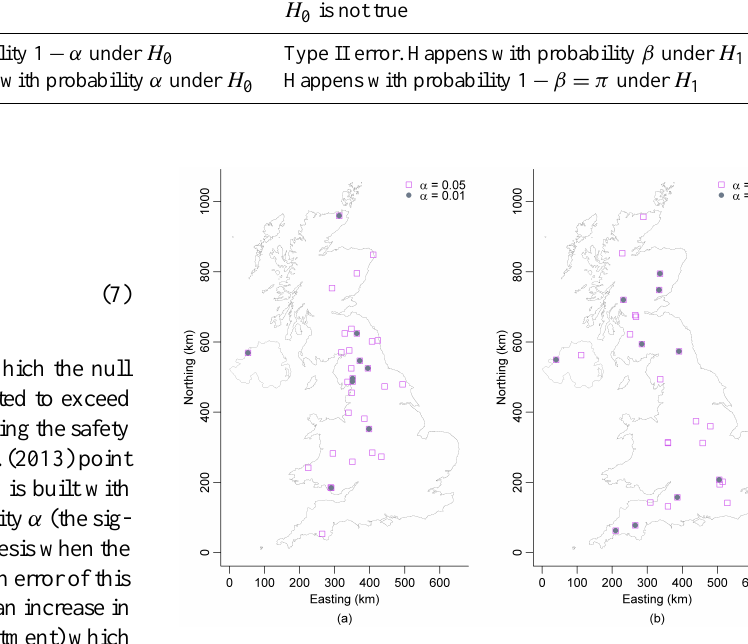
Fig. 12. (a) Sites for which the null hypothesis H 0 : β 1 ≤ log ( 1 . 2 )/ 85 is rejected. (b) Sites for which the null hypothesis H 0 : β 1 > log ( 1 . 2 )/ 85 is rejected. Results shown for two different significance levels α = 0 . 05 and α = 0 .